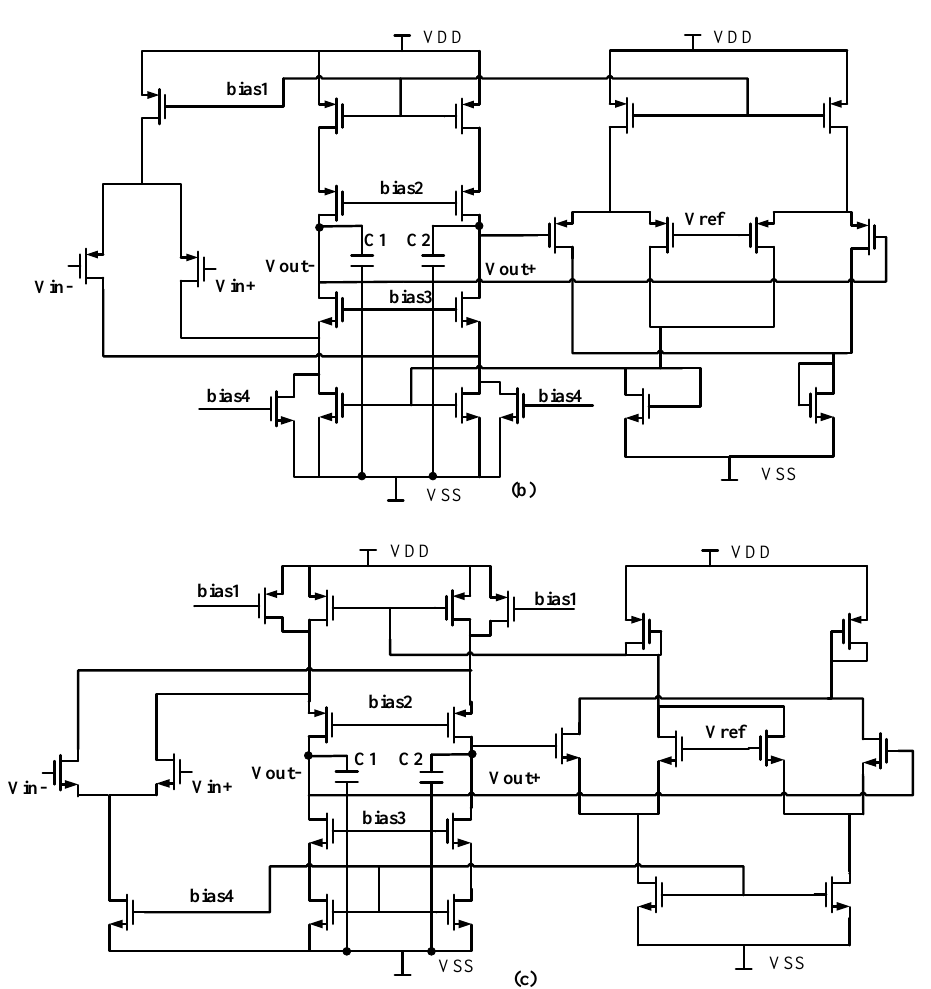
Figure 7. ( a ) Input stage transconductance operational amplifier with common-mode feedback circuit ( b ) Gain booster V n ; and, ( c ) Gain booster V p